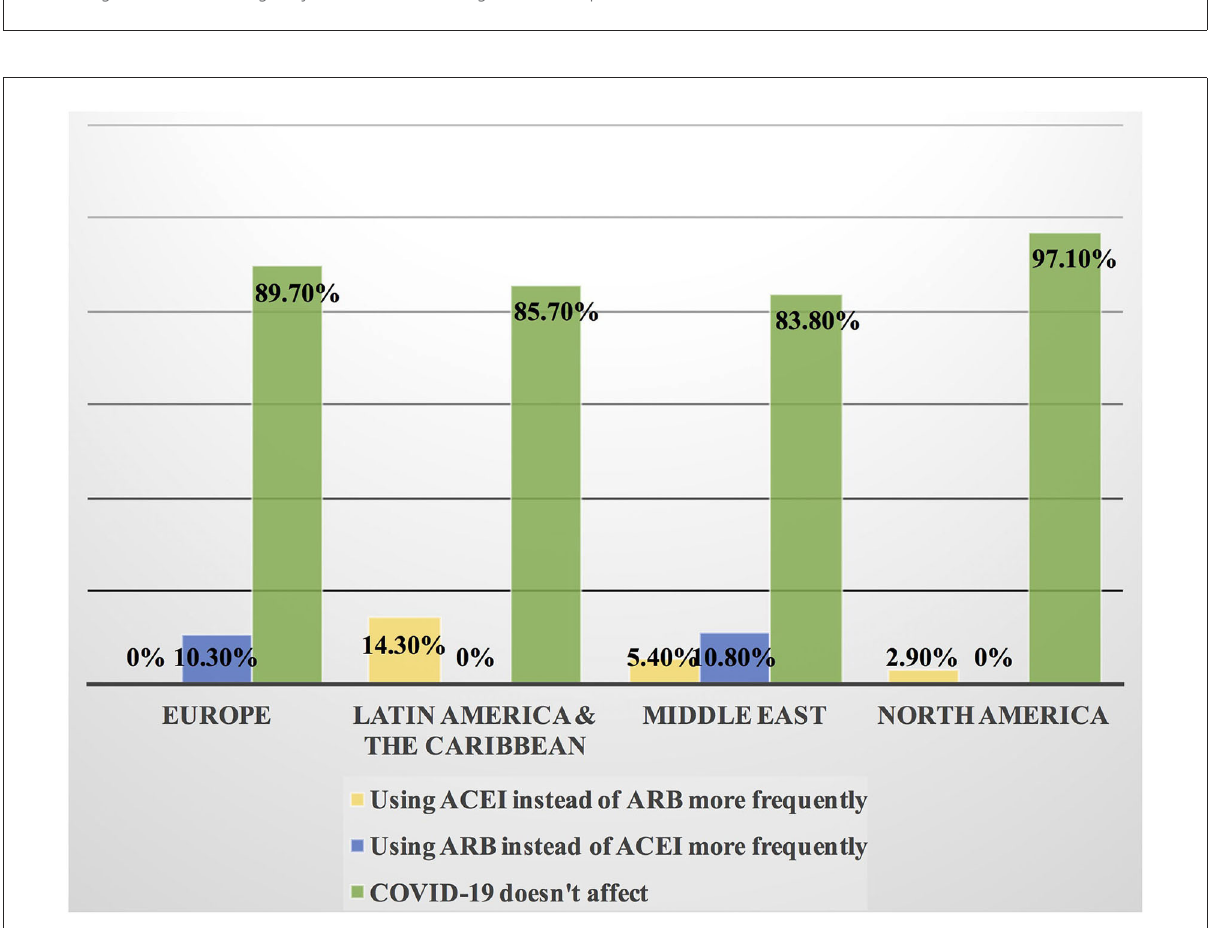
FIGURE9 Impact of the COVID-19 pandemic on the prescribing of ACEI vs. ARB among patients with cancer in different continents. Prescribing ACEI and ARB for patients with cancer by most of the cardiologists and oncologists was not affected by the COVID-19 pandemic globally; however, the highest rate of changing practice in the management was found in Latin America and the Caribbean where ACEI was prescribed more frequently and in Europe where ARB was prescribed more than ACEI. ACEI, angiotensin-converting enzyme inhibitor; ARB, angiotensin receptor